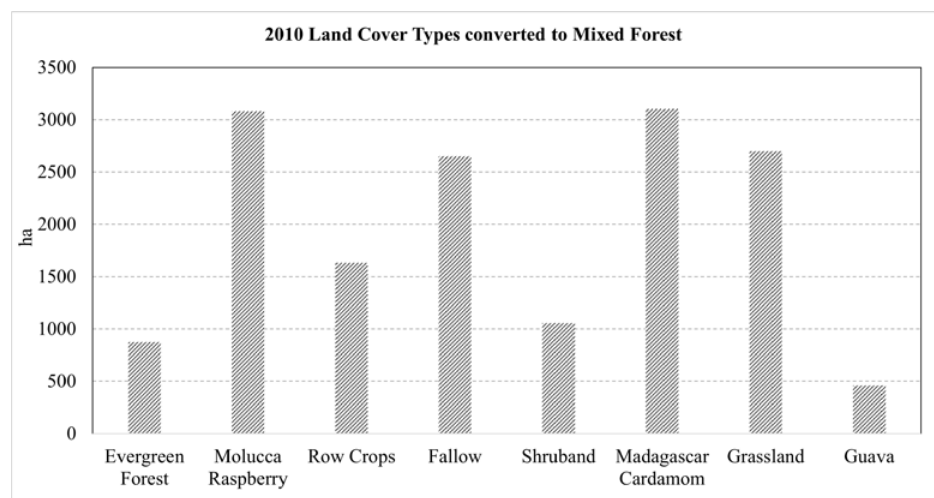
Figure 14. Percentage of classes in 2010 that were converted to Mixed Forest in 2019 within the BNR, shows a higher conversion of invasive plants—Molucca Raspberry, Madagascar Cardamom, and Guava—to Mixed Forest compared to Evergreen Forest.